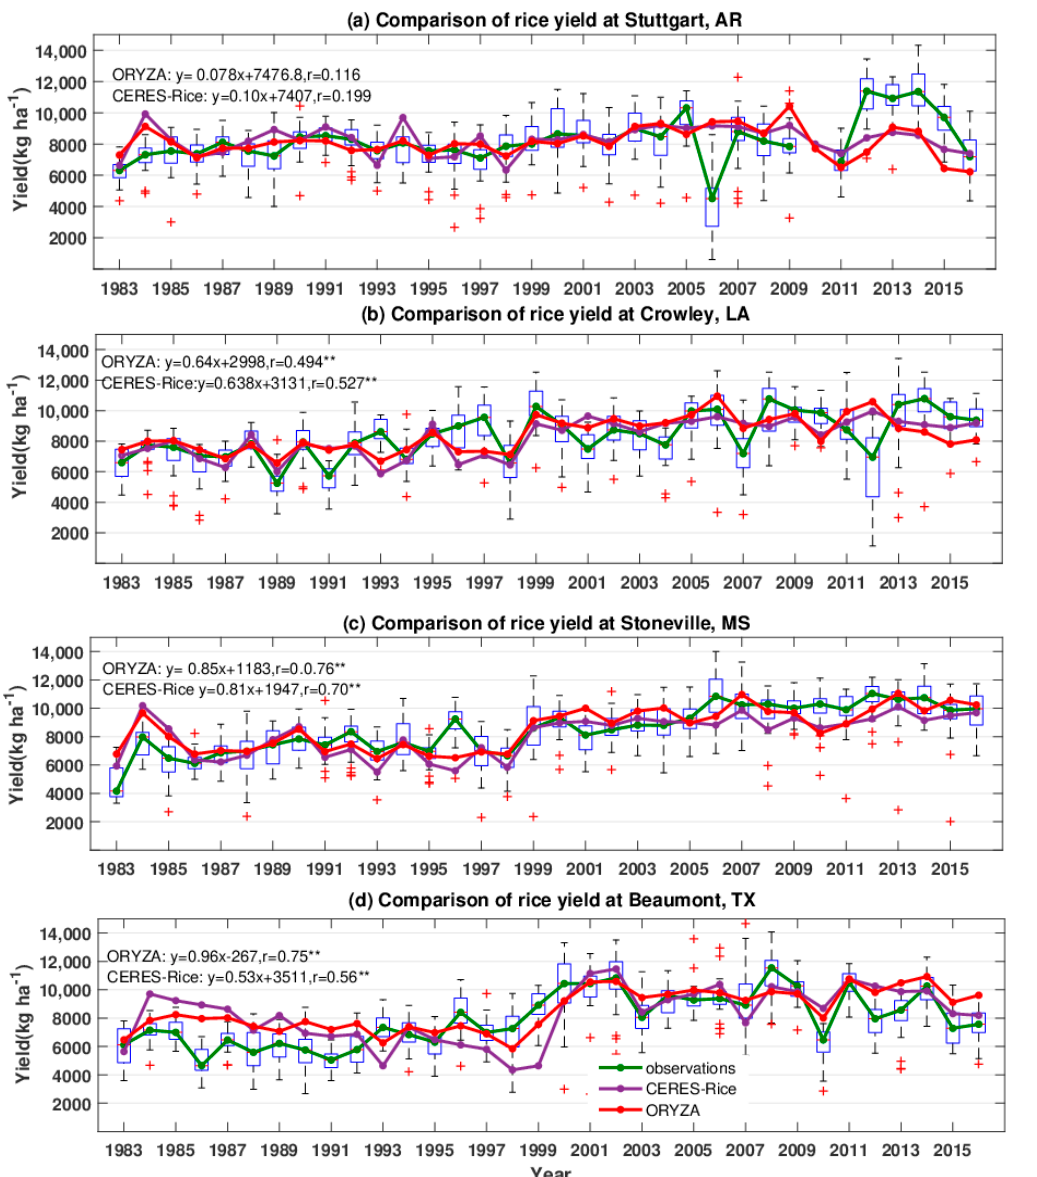
Figure 5. Comparison of simulated yield for cultivar Lemont (simulated for 1983–1998) and Cocodrie (simulated for 1999–2016) to observed a 50% percentile yield (green line) from the full cultivar set (n = 101 or less) that were grown during the particular year at ( a ) Stuttgart, AR, ( b ) Crowley, LA, ( c ) Stoneville, MS, and ( d ) Beaumont, TX. The box plot shows the variation of these observed rice yields. Top, middle, and bottom lines of each ‘box’ are the 25th, 50th, and 75th percentiles, and ends of the whiskers (lines extending from the boxes) mark the highest and lowest values of the data set that are within 1.5 times the interquartile range. Outliers were shown by the red plus ( + )